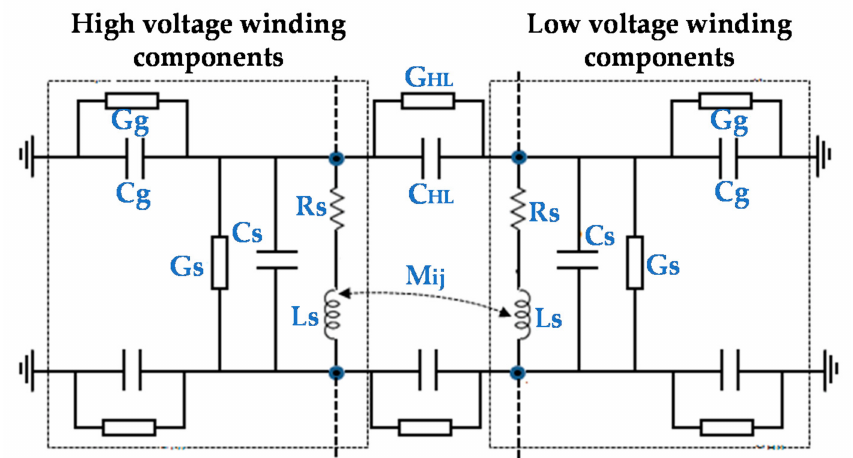
Figure 5. The resistance, inductance, and capacitance (RLC) ladder network for single disc wind— ing [30].